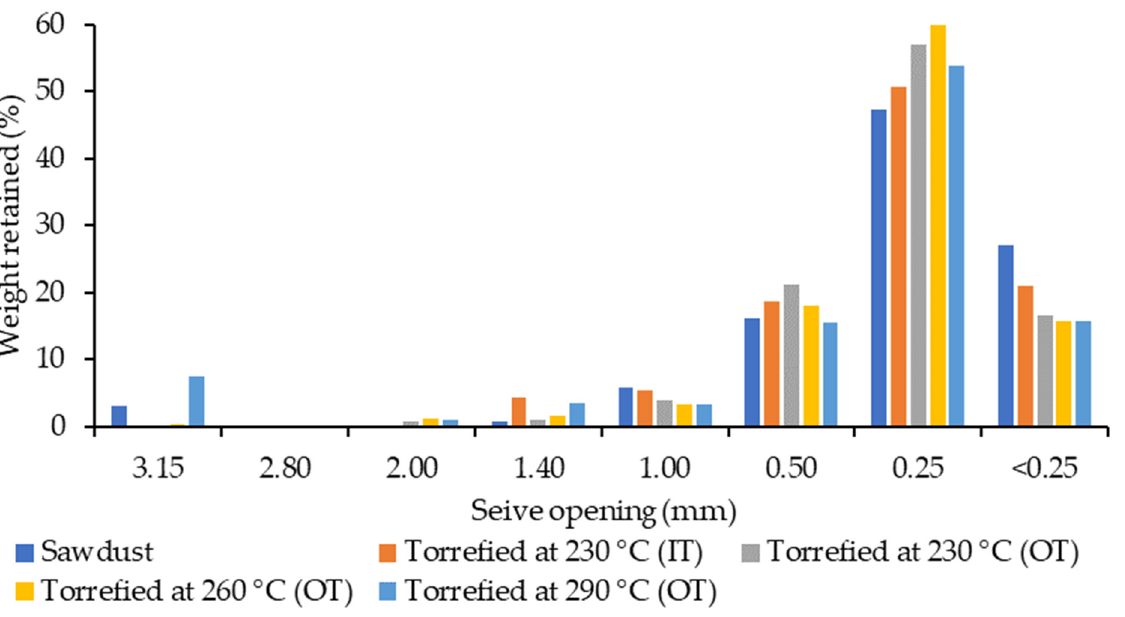
Figure 3. Particle size distribution of different raw and torrefied materials using inside temperature (IT) or outside temperature